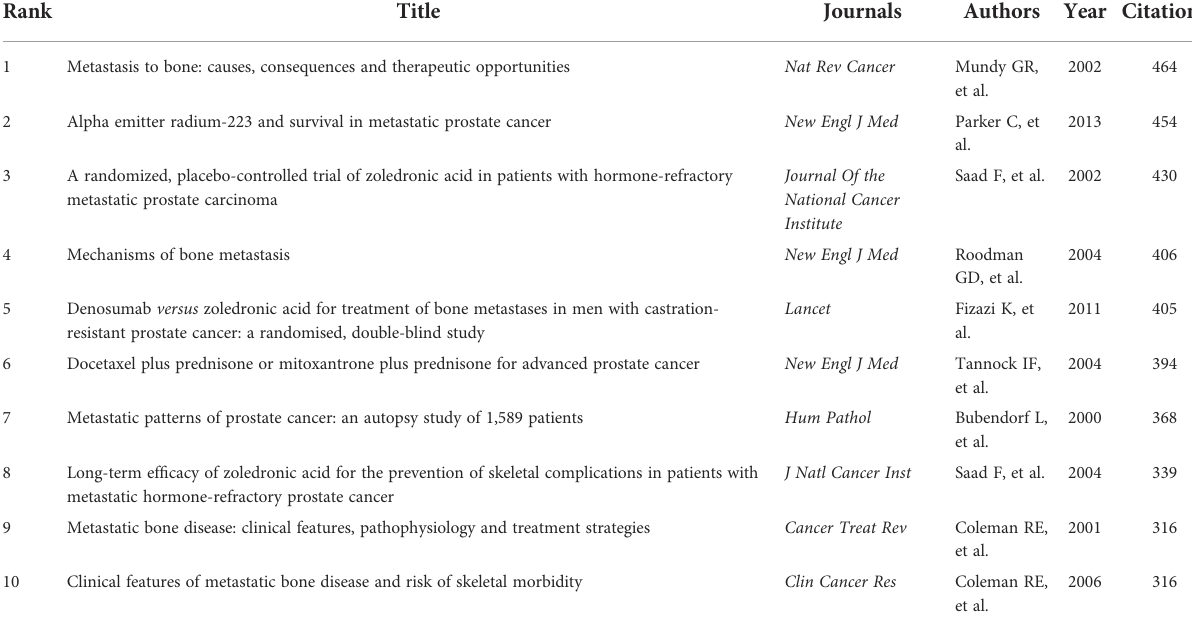
TABLE 5 Top 10 co-cited references concerning the research of bone metastases in prostate cancer.